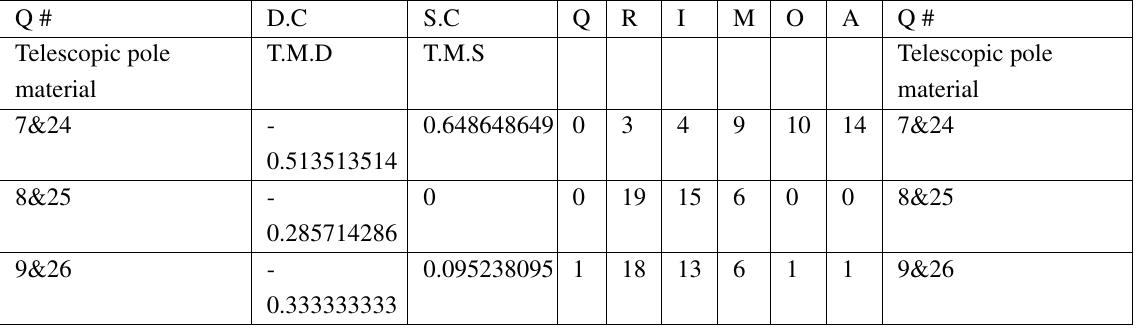
Table 9. The arrangement of customers’ requirements and the values of satisfaction and dissatisfaction factor for